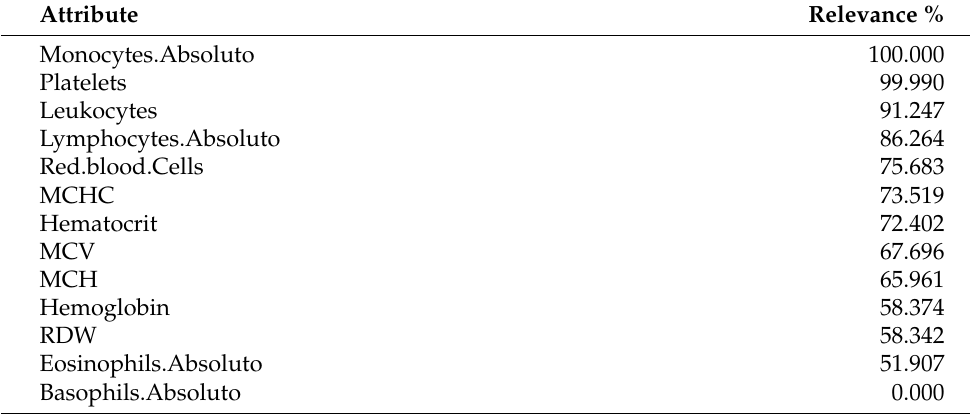
Table 15. Relevance of variables in the random forest training, for comparative purposes. Attribute Relevance % Monocytes.Absoluto 100.000